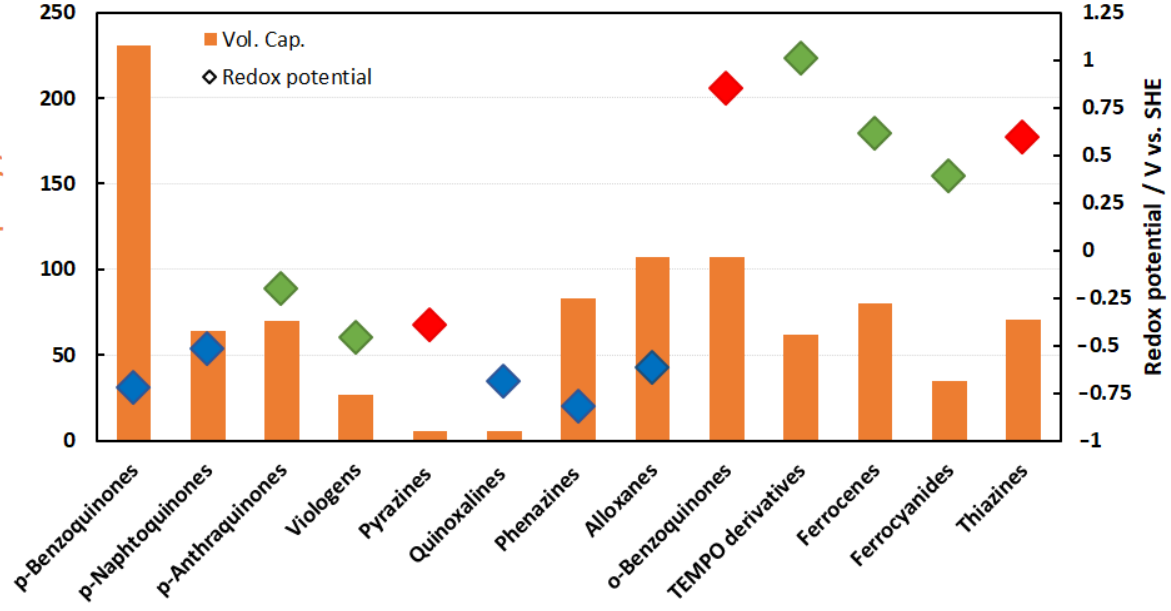
Figure 6. Redox potential ranges of redox couples discussed in this article. The color code of the bars indicates the pH regimes the redox potentials were measured, red for acidic pH range, green for neutral, and blue for alkaline pH range, grey means that alkaline as well as acidic electrolytes were considered.